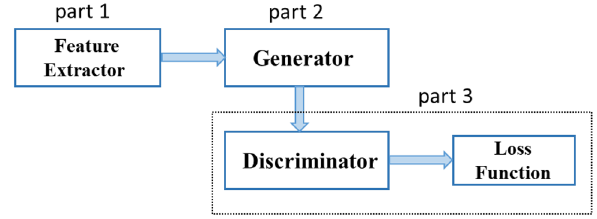
Figure 3. Network framework diagram of denoising model.